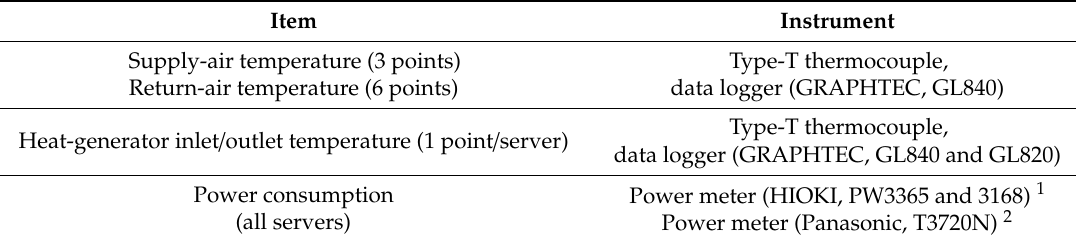
Table 8. Measured items and measurement instruments (experiments C and